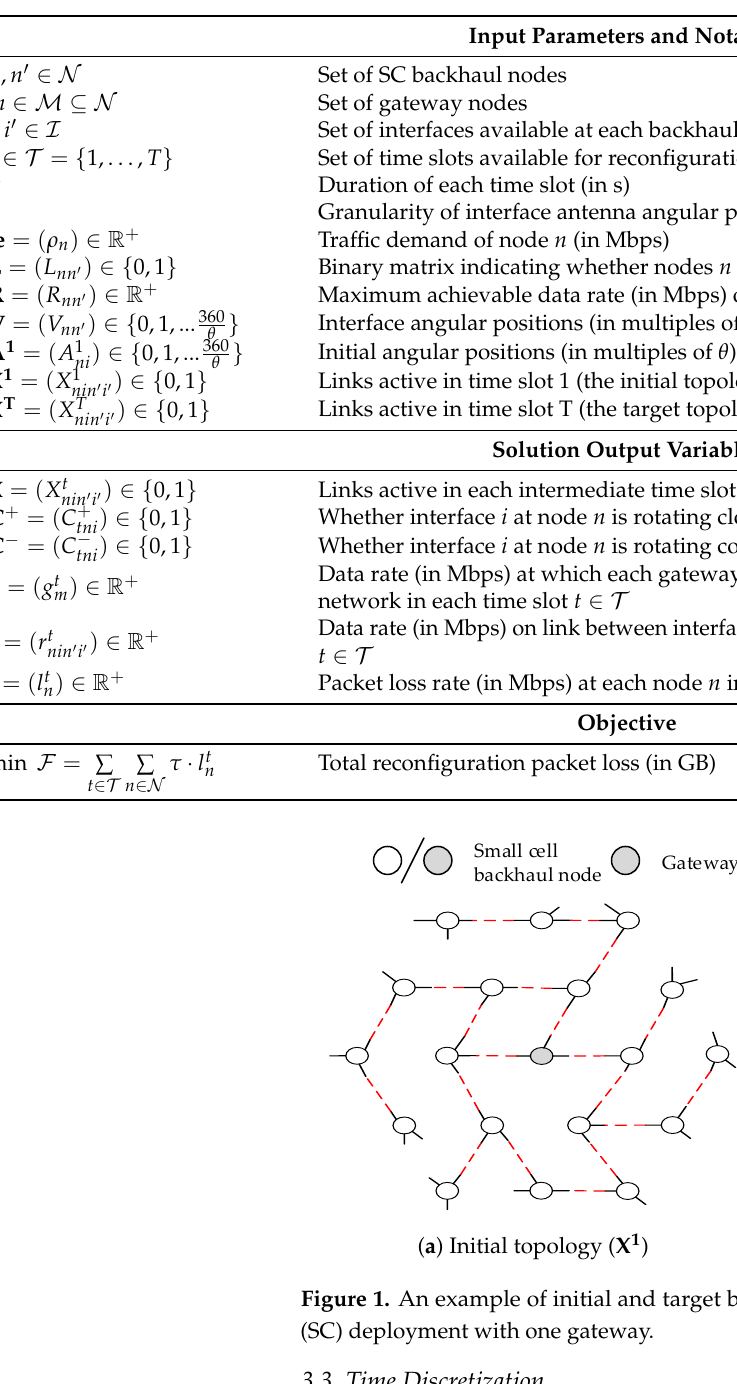
Table 1. Steerable backhaul reconfiguration problem definition and notation.